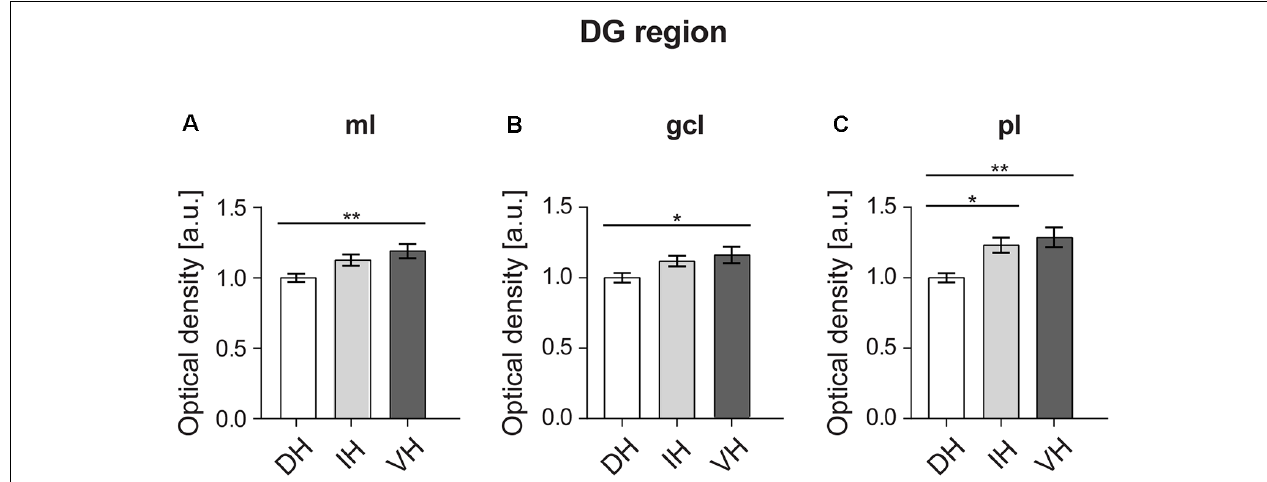
FIGURE 3 | In the DG, the dorsal component exhibits the lowest D2R expression. The molecular layer (ml) (A) and granule cell layer (gcl) of the ventral DG (B) exhibit higher D2R levels compared to the dorsal DG. The polymorphic layer (pl) (C) of the dorsal DG shows the lowest receptor expression as opposed to the ventro-intermediate DG. Values expressed in arbitrary units (a.u.). Error bars indicate standard error of the mean (SEM). ∗ p < 0.05 or ∗∗ p < 0.01. ml, molecular layer; gcl, granule cell layer; pl, polymorphic